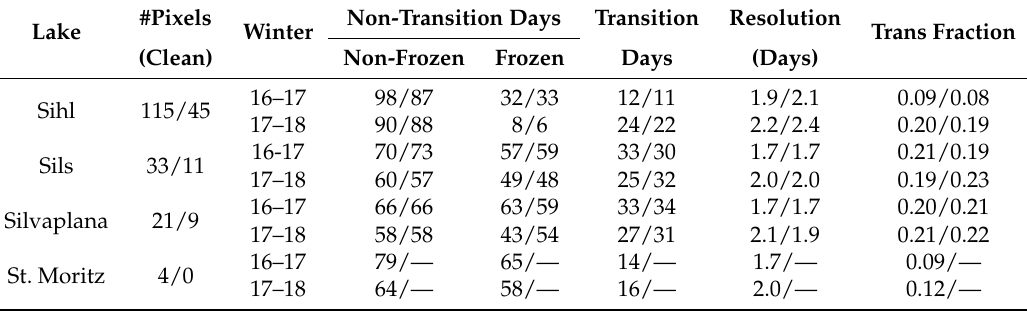
Table 5. Dataset statistics. M/V format displays the respective numbers of MODIS/VIIRS. The effective temporal resolution (shown as ‘resolution’) and fraction of transition dates over all processed dates (Trans fraction) are also shown. #Pixels (clean) displays the number of clean pixels per acquisition.